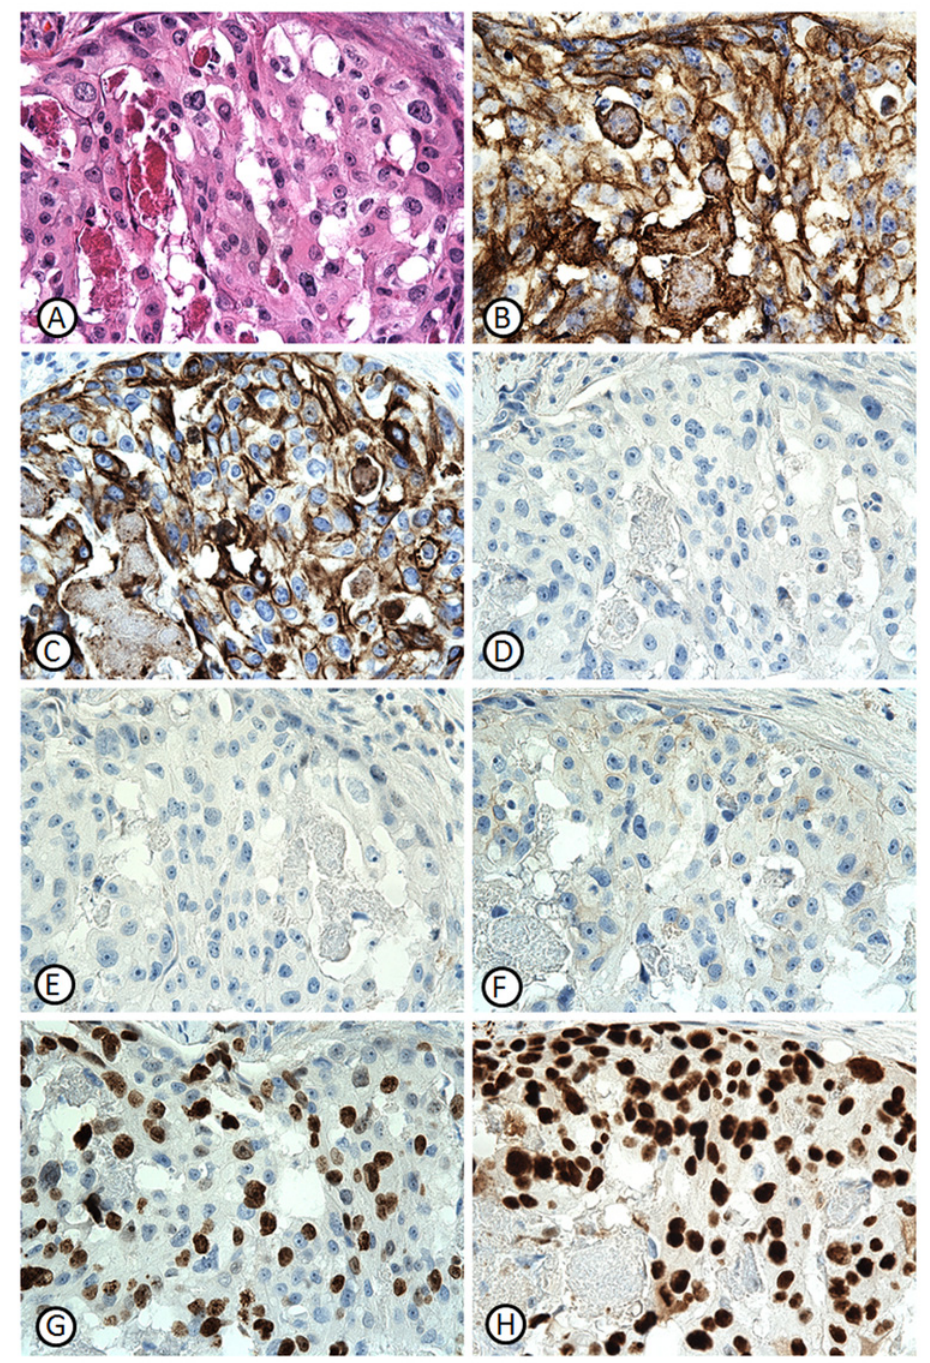
Fig 1. Immunoreactivity of 69-yr-old patient with T1bN0M0 TNBC. (A) Hematoxylin and Eosin (H&E), (B) EGFR ( > 70%), (C) CK5/6 ( > 70%), (D) ER, (E) PR, (F) HER2, (G) Ki-67 ( > 60%), and (H) P53 ( > 90%). The patient was undergone BCT, had 3.8 event free survival and 22.8 months overall